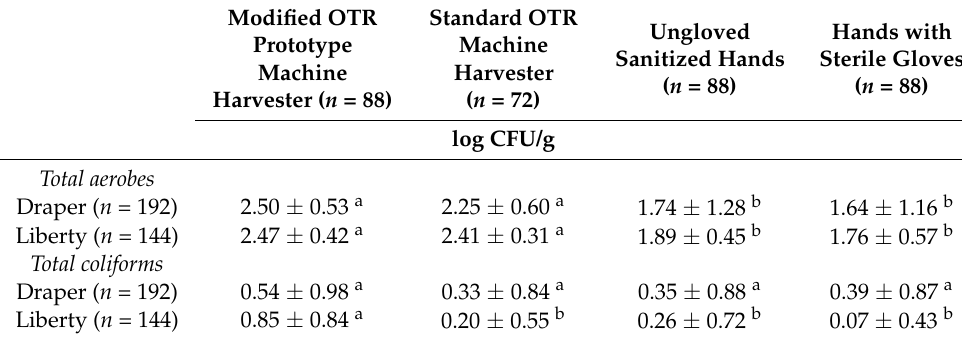
Table 4. Microbial loads on sampled fresh blueberries of different cultivars as affected by the harvesting